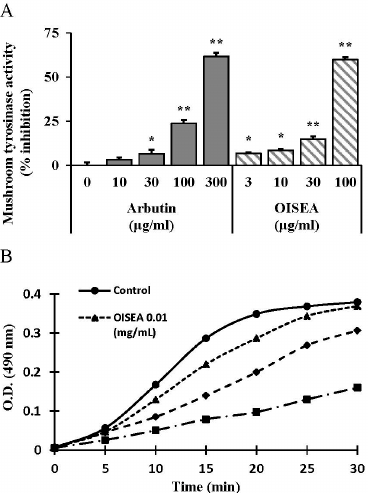
Figure 2. Inhibitory effects of OISEA on mushroom tyrosinase activity. ( A ) Different concentrations of OISEA or arbutin were incubated with the same units of mushroom tyrosinase. Following incubation, amounts of dopachrome produced were determined at 490 nm spectrophotometrically. ( B ) Effects of OISEA on the monophenolase activity of tyrosinase. Enzyme activity was tested in the presence of L -tyrosine, as substrate. Results are presented as the means ± SD of three experiments. * p < 0.05, ** p < 0.01, versus non-treated controls, Arb: Arbutin.